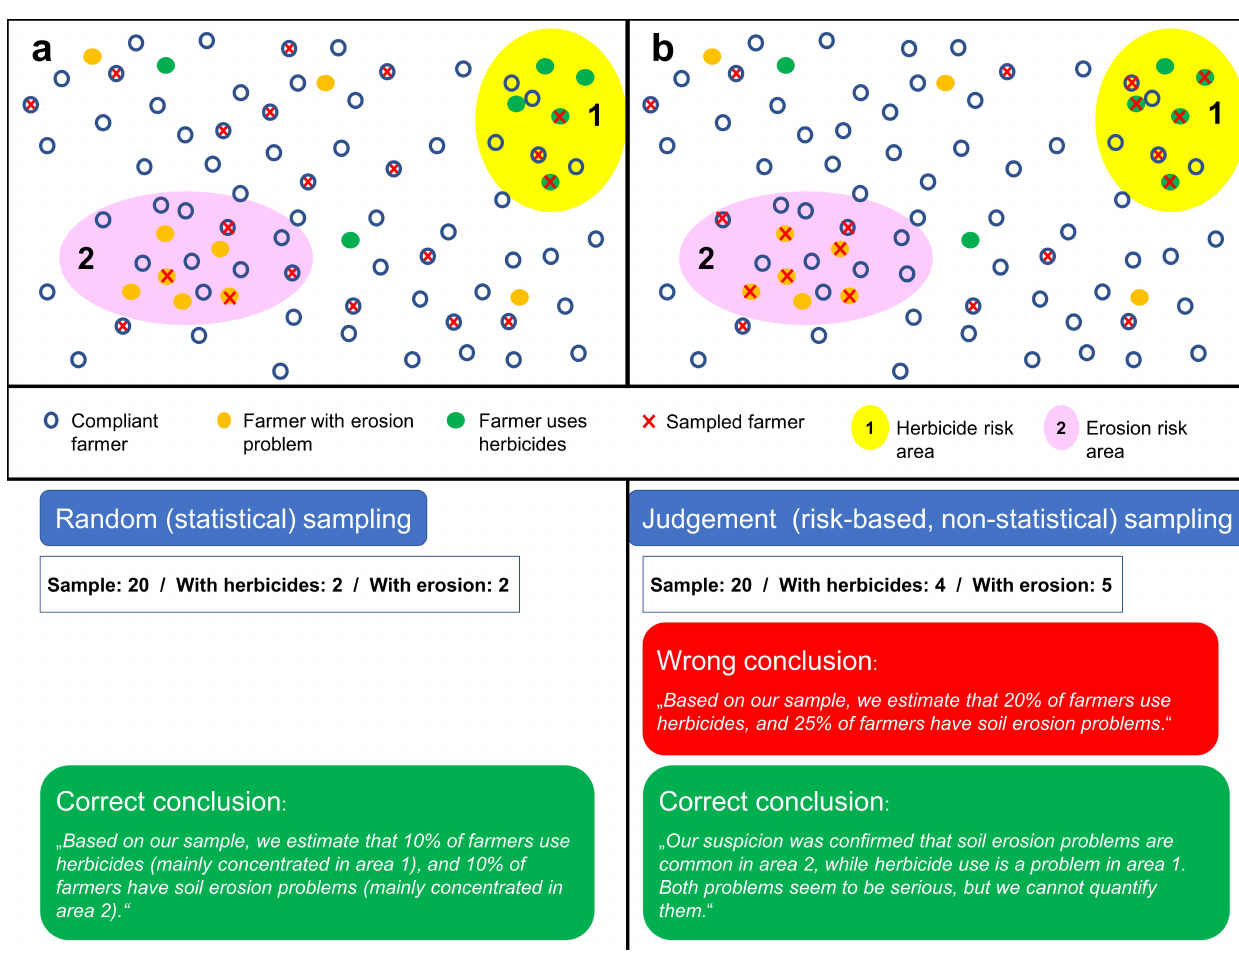
Figure 3. (a) Random (statistical) vs. (b) risk-based (non-statistical) sampling. In both cases, the group has 80 members, 9 of whom (11%) with erosion problems, and 7 (9%) with herbicide use. The sample is 20 in both cases. While (a) allows to estimate the probable dimension of the two problems, (b) does not. Therefore, the conclusion in the red box is